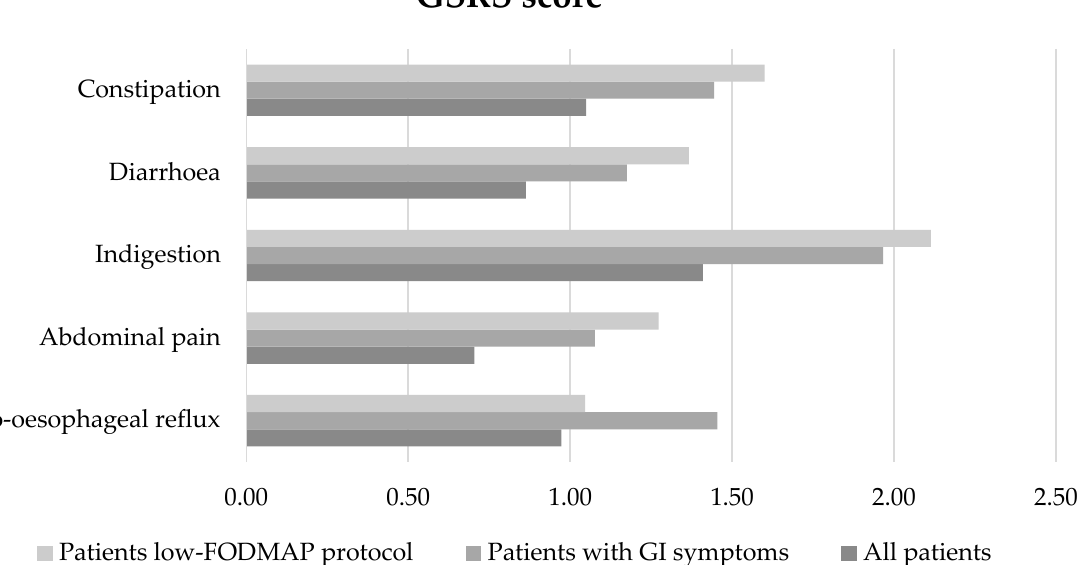
Table 3. IBS severity score in all FD patients assessed (n. 36): 33.3% presented severe GI